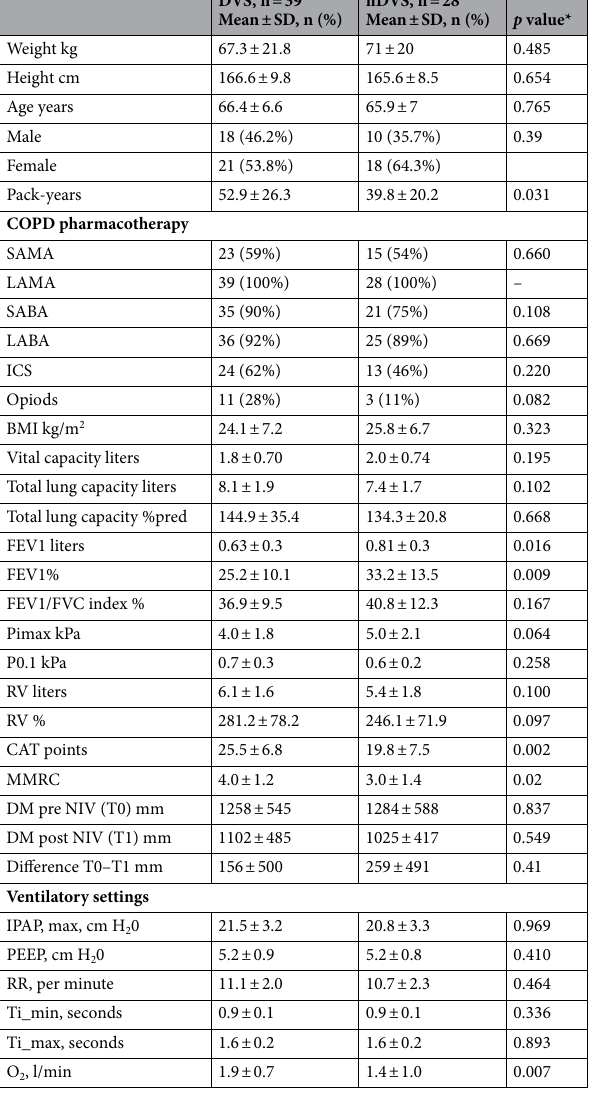
Table 1. Subgroup baseline characteristics. * p value based on t-test for continuous variables and on chi-square test for categorial